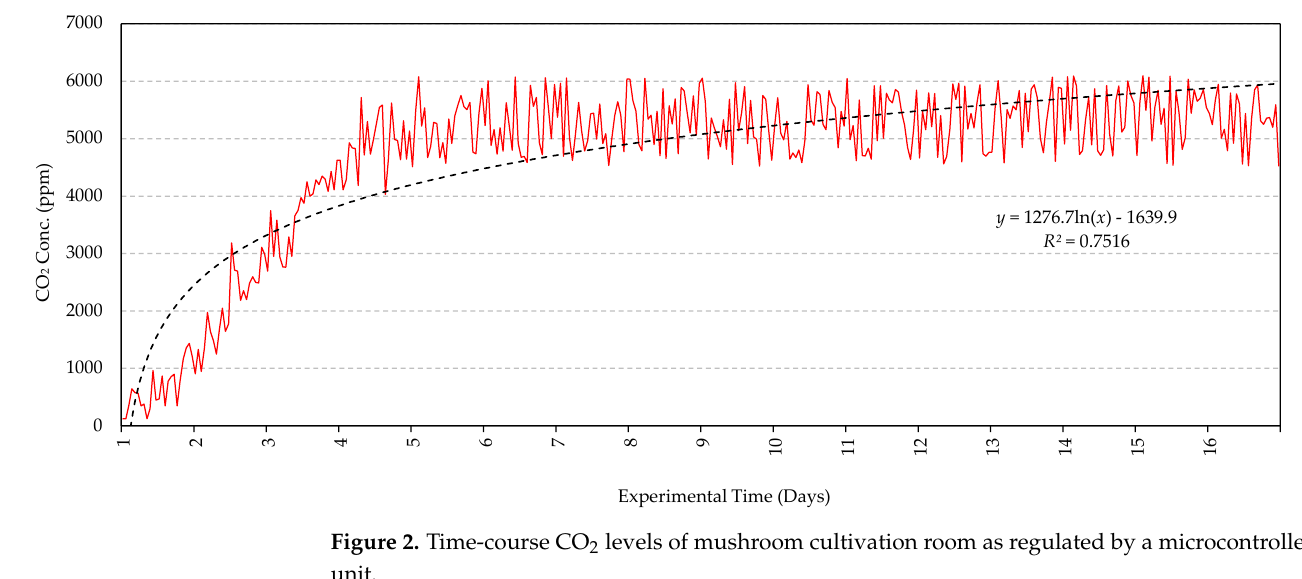
Figure 2. Time-course CO 2 levels of mushroom cultivation room as regulated by a microcontroller unit.